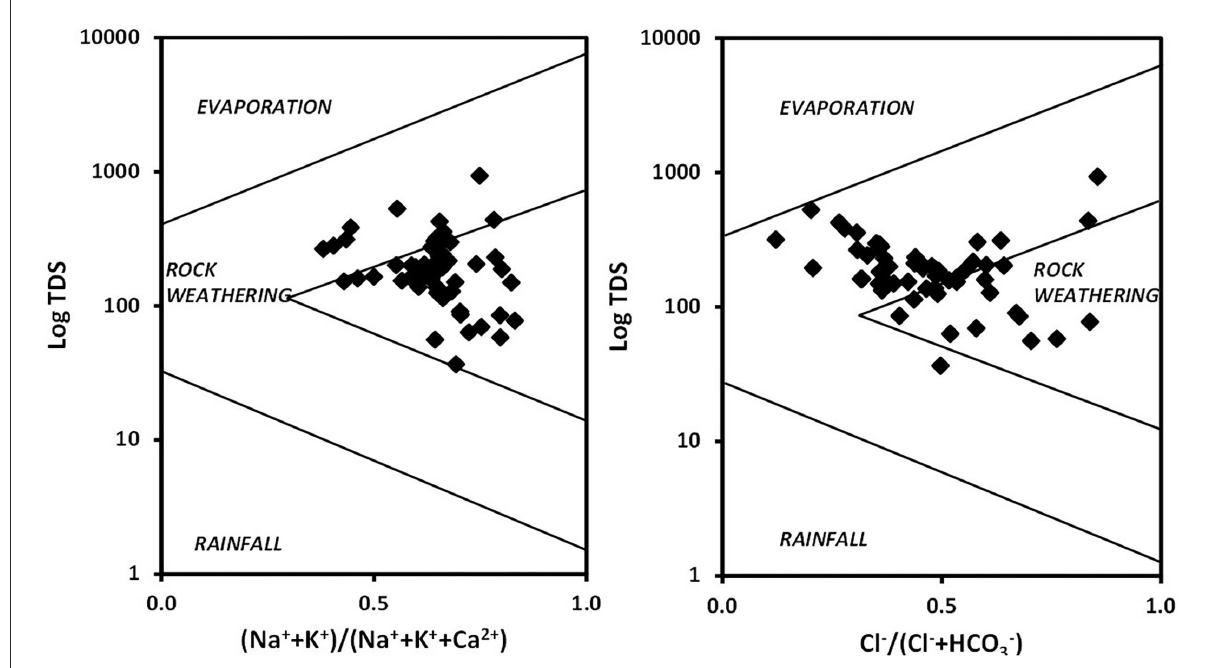
FIGURE4 Gibbs’ diagram pinpointing the principal mechanism dominating groundwater